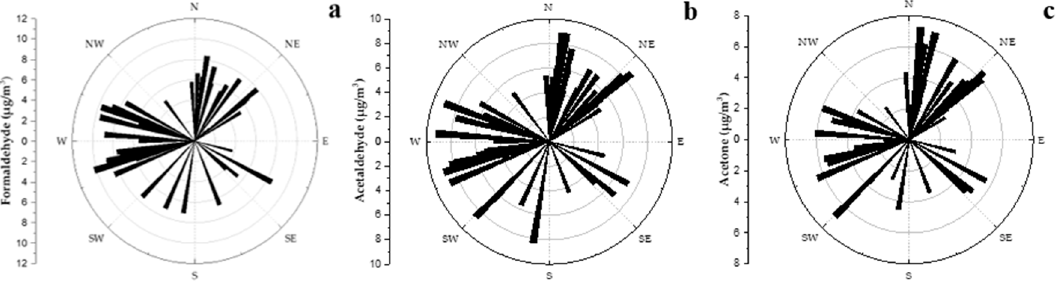
Figure 5. Correlation between the mass concentrations of formaldehyde ( a ), acetaldehyde ( b ), acetone ( c ), and wind direction at MC from 16 to 25 January 2019.